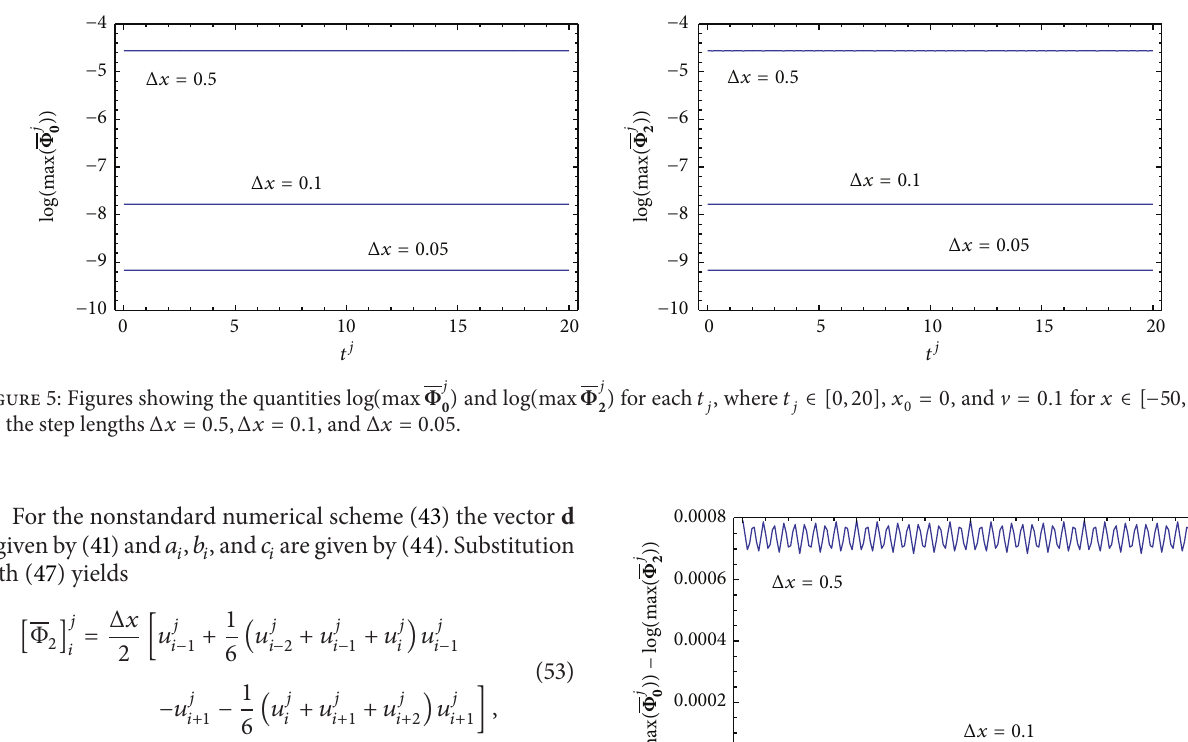
Figure6:Figuresshowingthequantitieslog ( max Φ for each 𝑡 𝑗 , where 𝑡 𝑗 ∈ [0,20] , 𝑥 0 = 0 , and V = 0.1 for 𝑥 ∈ [−50, 70] for the step lengths Δ𝑥 = 0.5, Δ𝑥 = 0.1 , and Δ𝑥 = 0.05